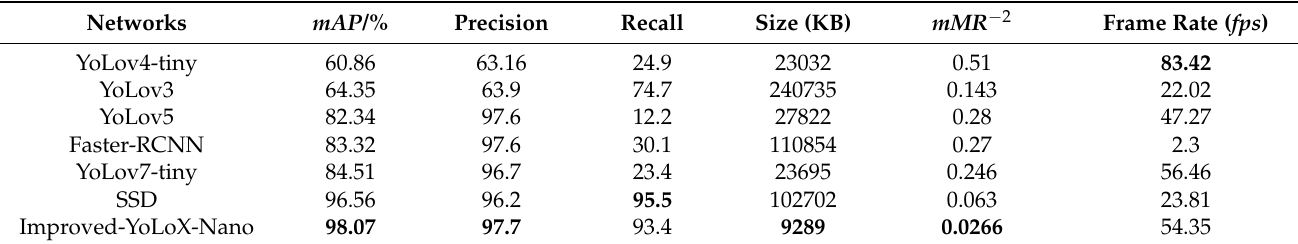
Table 3. Performance comparison of various network